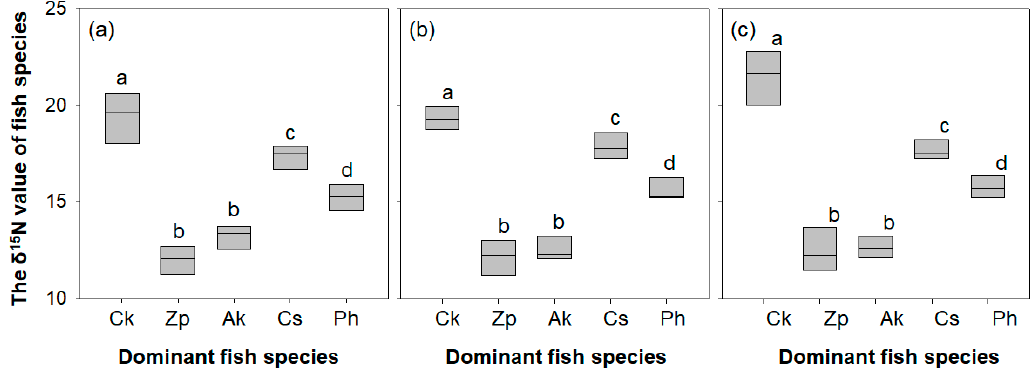
Figure 6. The δ 15 N value of each fish species in three study sites (from the left, sites 2, 4, and 8) located in the upper parts of the Geum River. Ck, Coreoperca kawamebari ; Zp, Zacco platypus ; Ak, Acheilognathus koreensis ; Cs, Coreoleuciscus splendidus ; Ph, Pungtungia herzi . Means labeled with a different letter indicate statistical subgroups defined by the post hoc test (Tukey honest significant difference (HSD), P = 0.05). ( a ) site 2, ( b ) site 4, and ( c ) site 8.